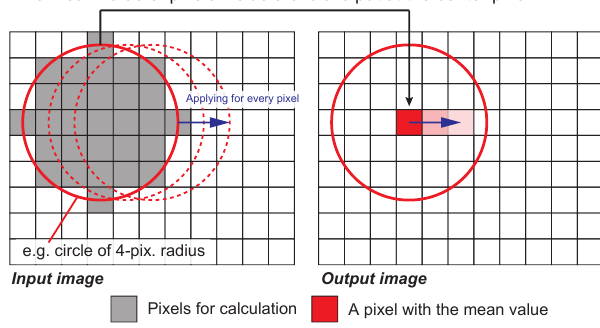
Figure 2. Concept of a focal statistics filter to reduce